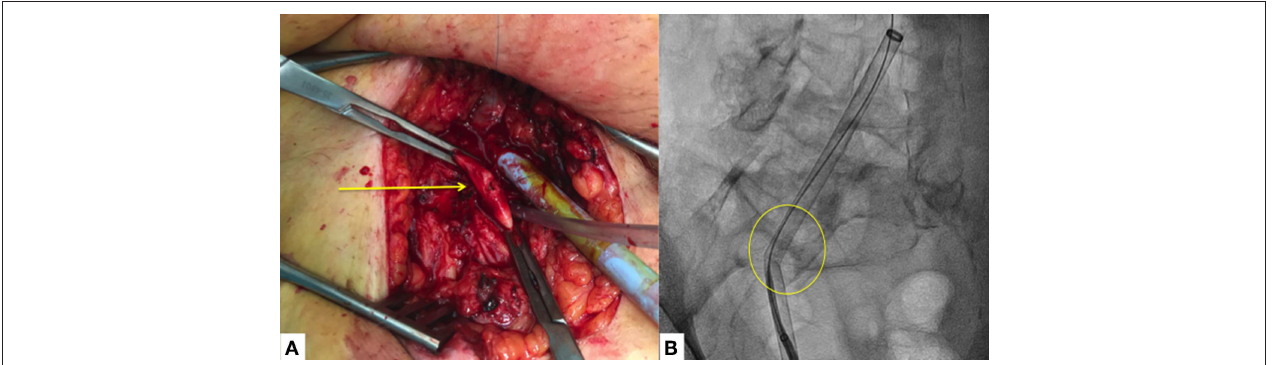
FIGURE 1 | Vascular access complications. (A) Major vascular access complication with small laceration of the femoral artery with important fibrotic (adhesions) tissue (yellow arrow). (B) Sheath’s kinking which does not allow the advance of the transeptal puncture catheter (yellow circle), due to important adhesions between the femoral artery and vein with severe calcified and tortuous iliac